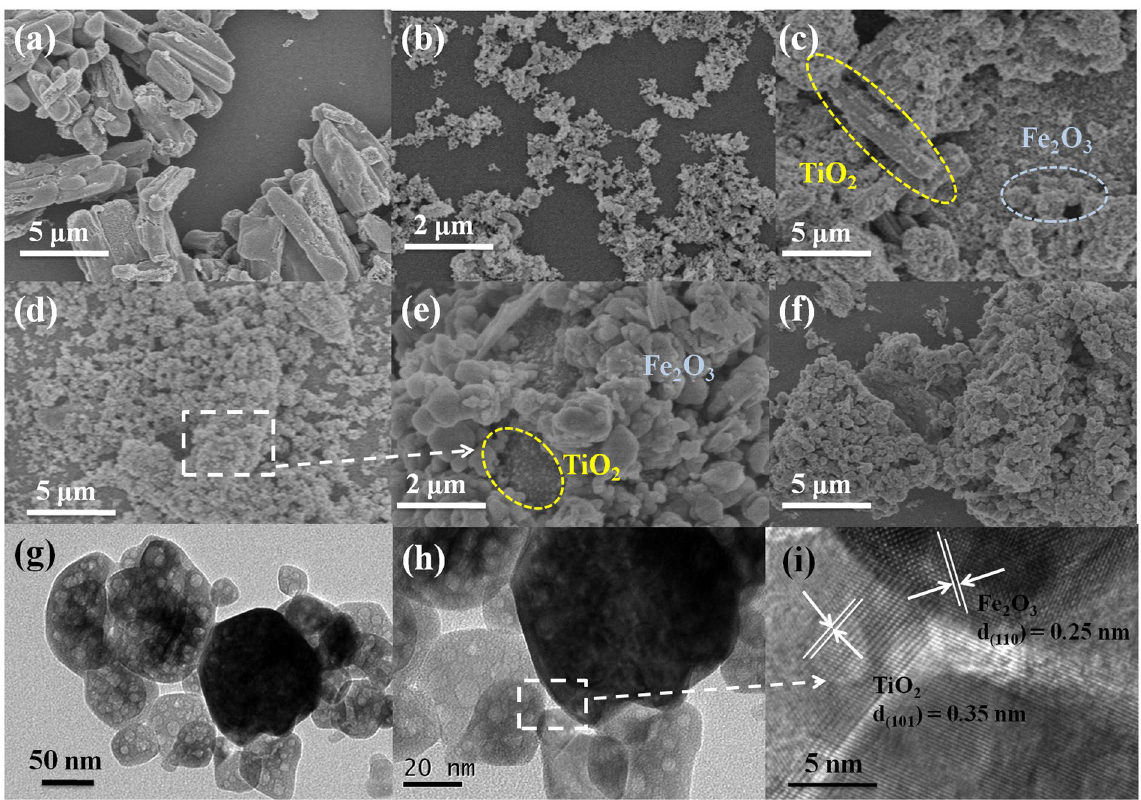
Figure 2. SEM images of ( a ) TiO 2 , ( b ) α -Fe 2 O 3 , ( c ) TiO 2 /Fe 2 O 3 -3; ( d , e ) TiO 2 /Fe 2 O 3 -5 ( f ) TiO 2 /Fe 2 O 3 -7, and ( g , h ) TEM images of as-prepared